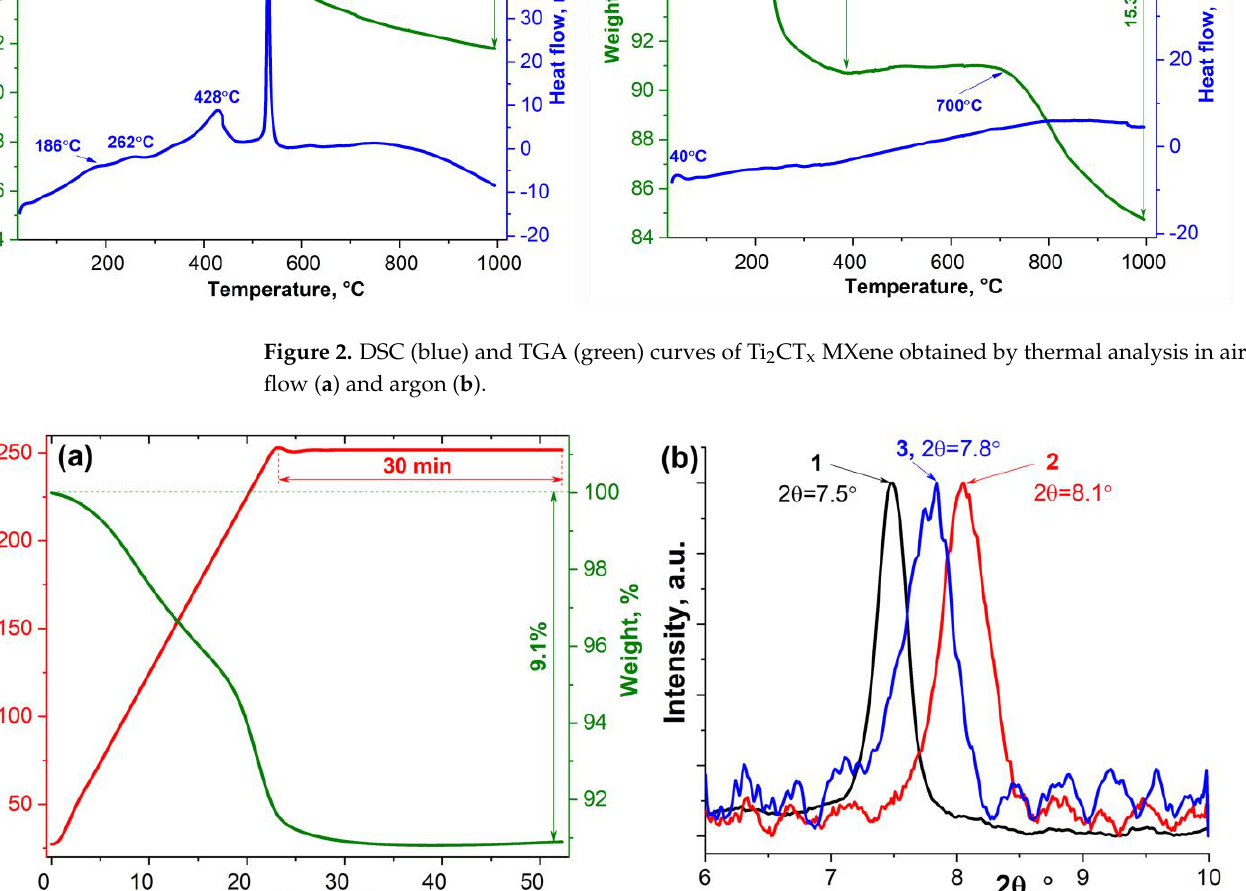
Figure 3. TGA curve after heating the resulting accordion-like Ti 2 CT x MXene powder in an argon flow to the temperature 250 ° С and holding for 30 min ( a ), and also sections of the X-ray diagram in the interval 2 θ = 6– 10° showing the reflex position (002) ( b ) in the initial powder (1), after heating in an argon flow to 250 ° С for 30 min (2) and after holding the sample in a humid atmosphere for 2 days (3).